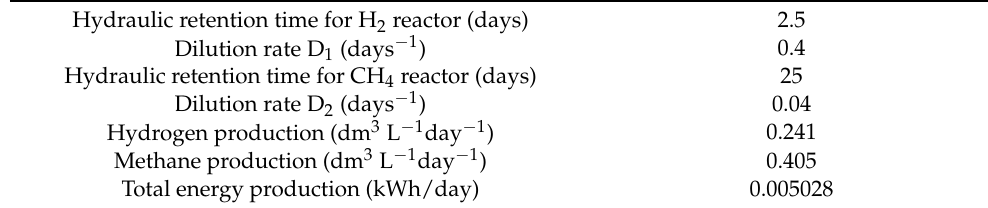
Table 5. Experimental results obtained during the TPAD continuous tests ( γ = 0.1and S 0i = 50 g/L). Hydraulic retention time for H 2 reactor (days)